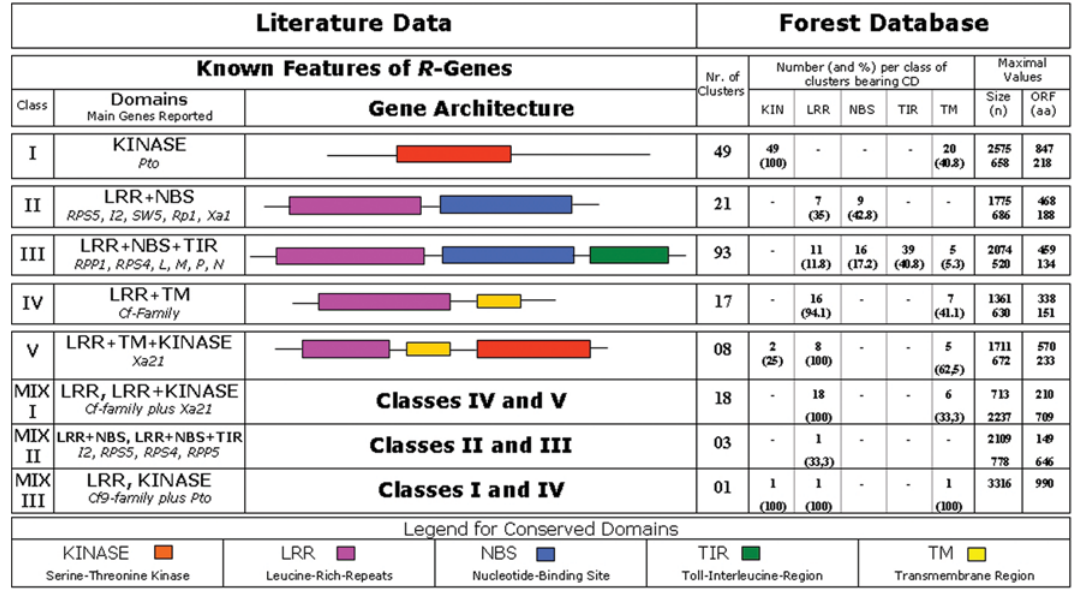
Figure1 -Representationofmain R -genesclassesconsideringthepresenceandpositionofconserveddomainsfromliteraturedata,ascomparedwith Eu- calyptus clustersfromFORESTdatabase.Foreachclassthedataaboutsignificantalignmentsto R -genesisgiven,includingfollowinginformation:num- ber of clusters identified for each class (clusters aligning with more than one class are not included), number and percentage of clusters per class bearing indicated conserved domains, size range (maximal and minimum) of sequence in nucleotides (n) and of ORF in amino-acids (aa). Abbreviation: CD = Conserved